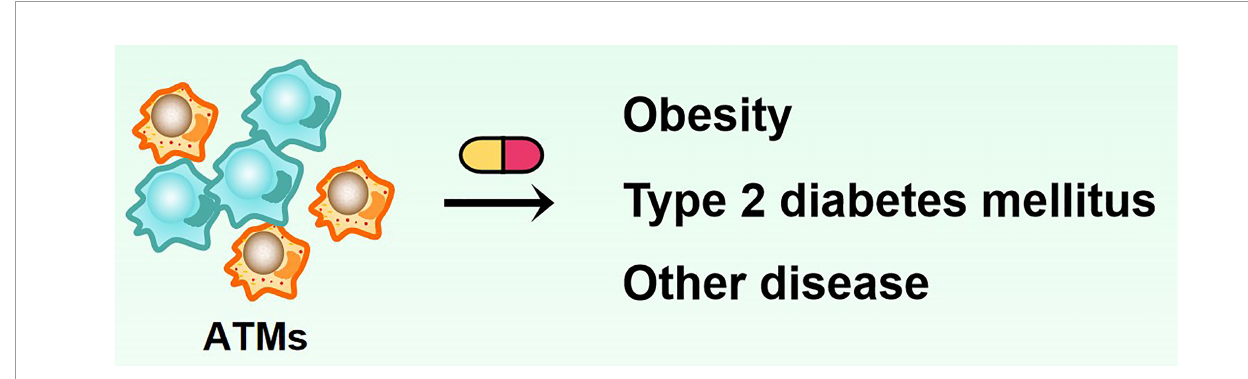
FIGURE 4 | Adipose tissue macrophages can be used as a potential therapeutic target for treating obesity and